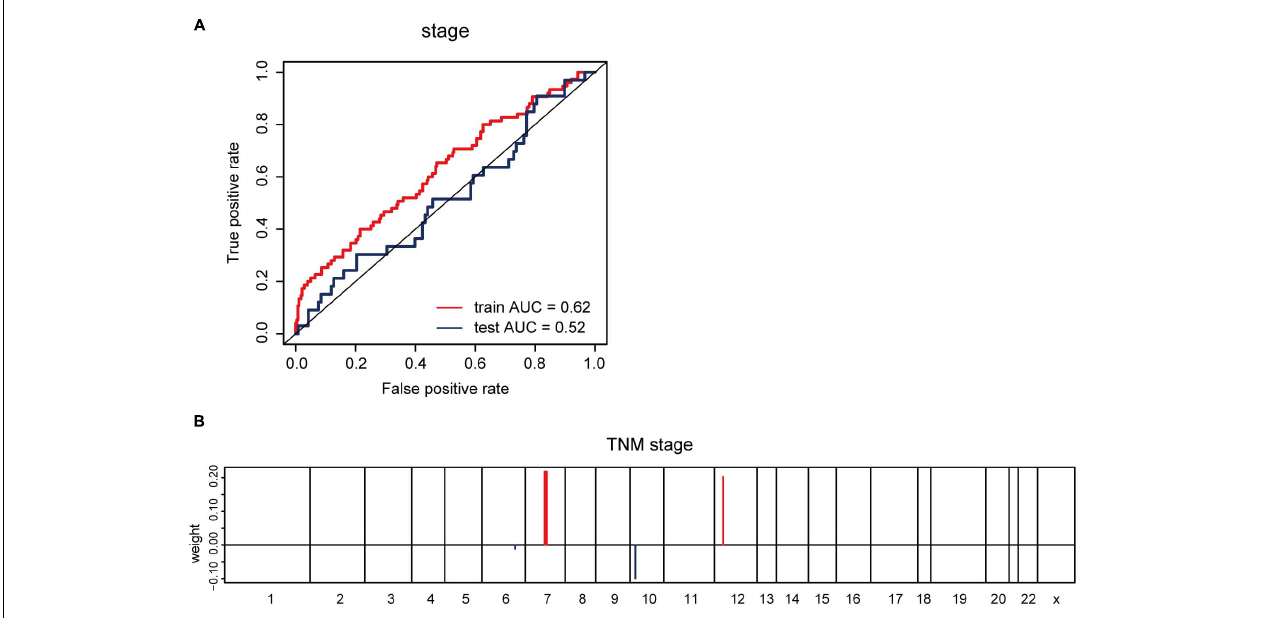
FIGURE 5 | CNV-based prediction of clinical features. (A) ROC curves and corresponding AUC values for CNV-based prediction of clinical stage (stage I–II vs. stage III–IV) in the TCGA training and test sets. (B) Elastic Net-selected CNV segments and whole chromosomal arms and their coefficients for prediction model for pathological